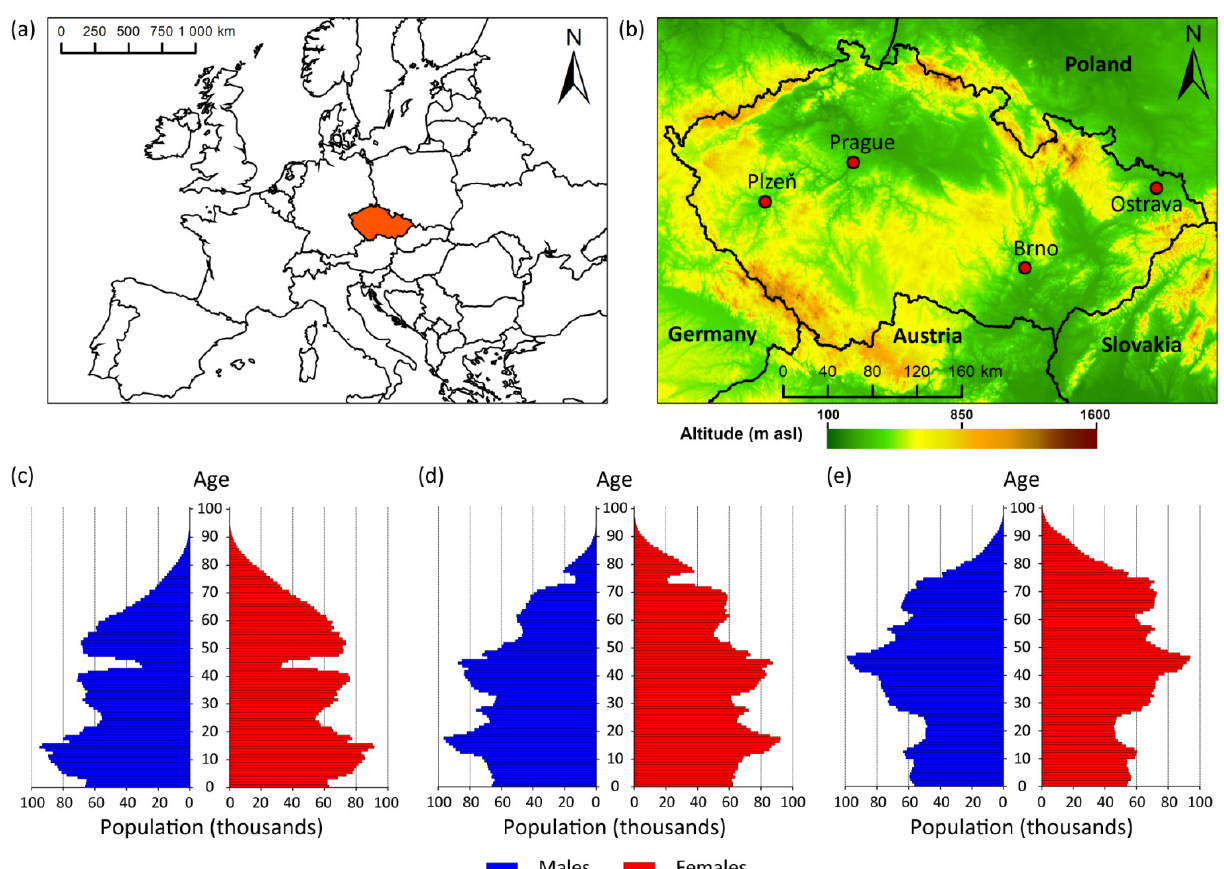
Figure 1. Location of the Czech Republic in Europe ( a ), physical geographical map of the Czech Republic ( b ), and age pyramids for 31 December 1961 ( c ), 31 December 1991 ( d ), and 31 December 2020 ( e ) (data in [64]).